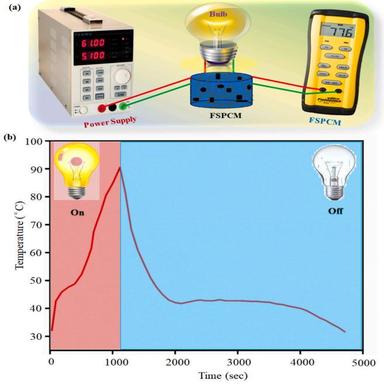
(a) Schematic diagram of an electro-to-thermal conversion of the device, and (b) the temperature fluctuation curve of a composite was generated during on/off power operation.